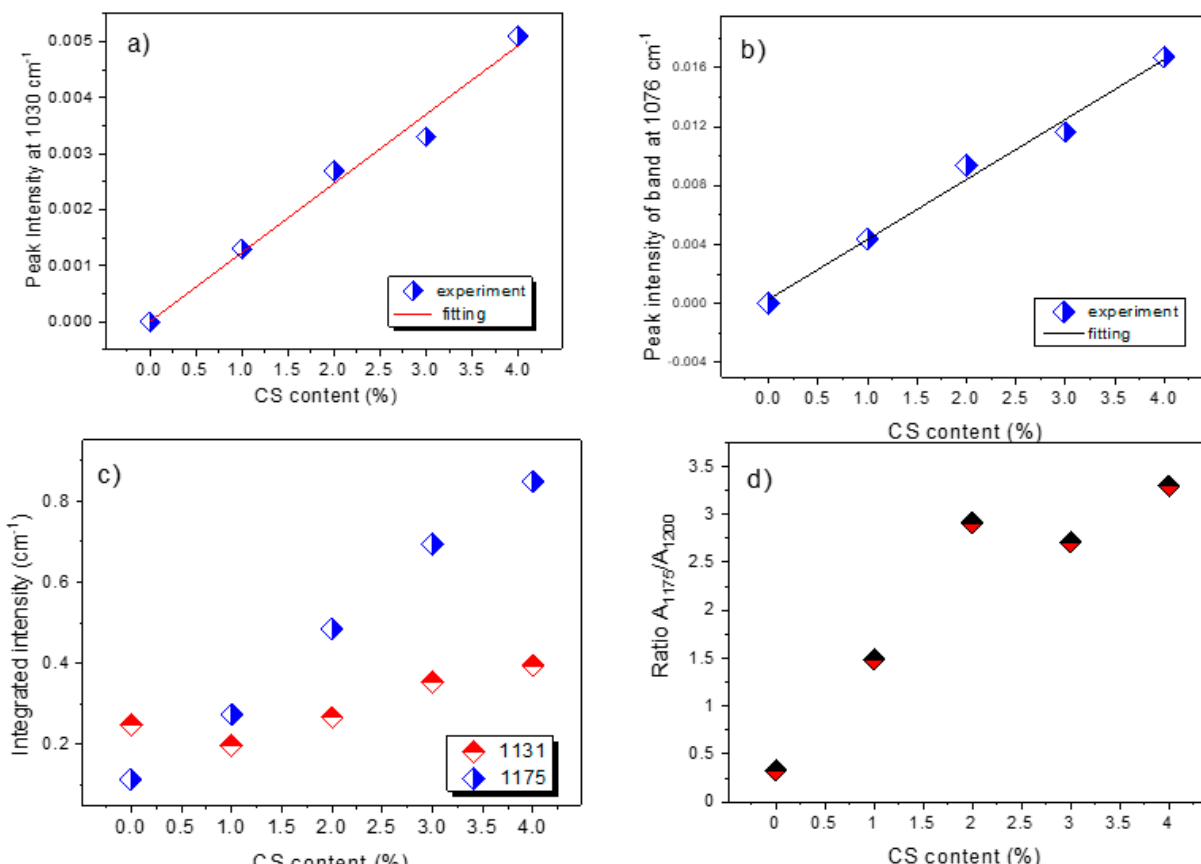
Figure 8. The dependence of the peak intensity vs CS content for C-O stretching vibrational bands at ( a ) 1030 and ( b ) 1076 cm − 1 obtained after FTIR spectra fitting in the region 900–1250 cm − 1 . The dependence of ( c ) the integrated intensity of bands at 1131 and 1175 cm − 1 and ( d ) the integrated intensity ratio of (A1175/A1200) vs. CS content obtained after FTIR spectra fitting in the region 900–1350 cm − 1 as shown in Figure